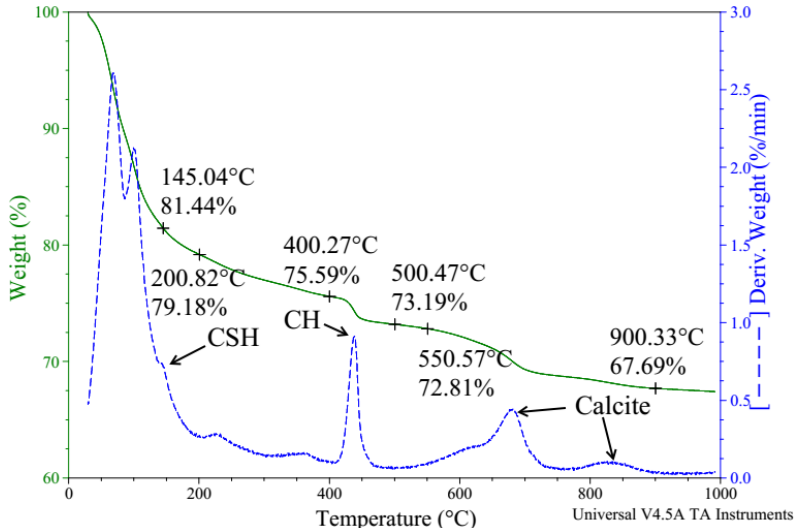
Figure 16. TGA/DTG observations of plain cement paste.